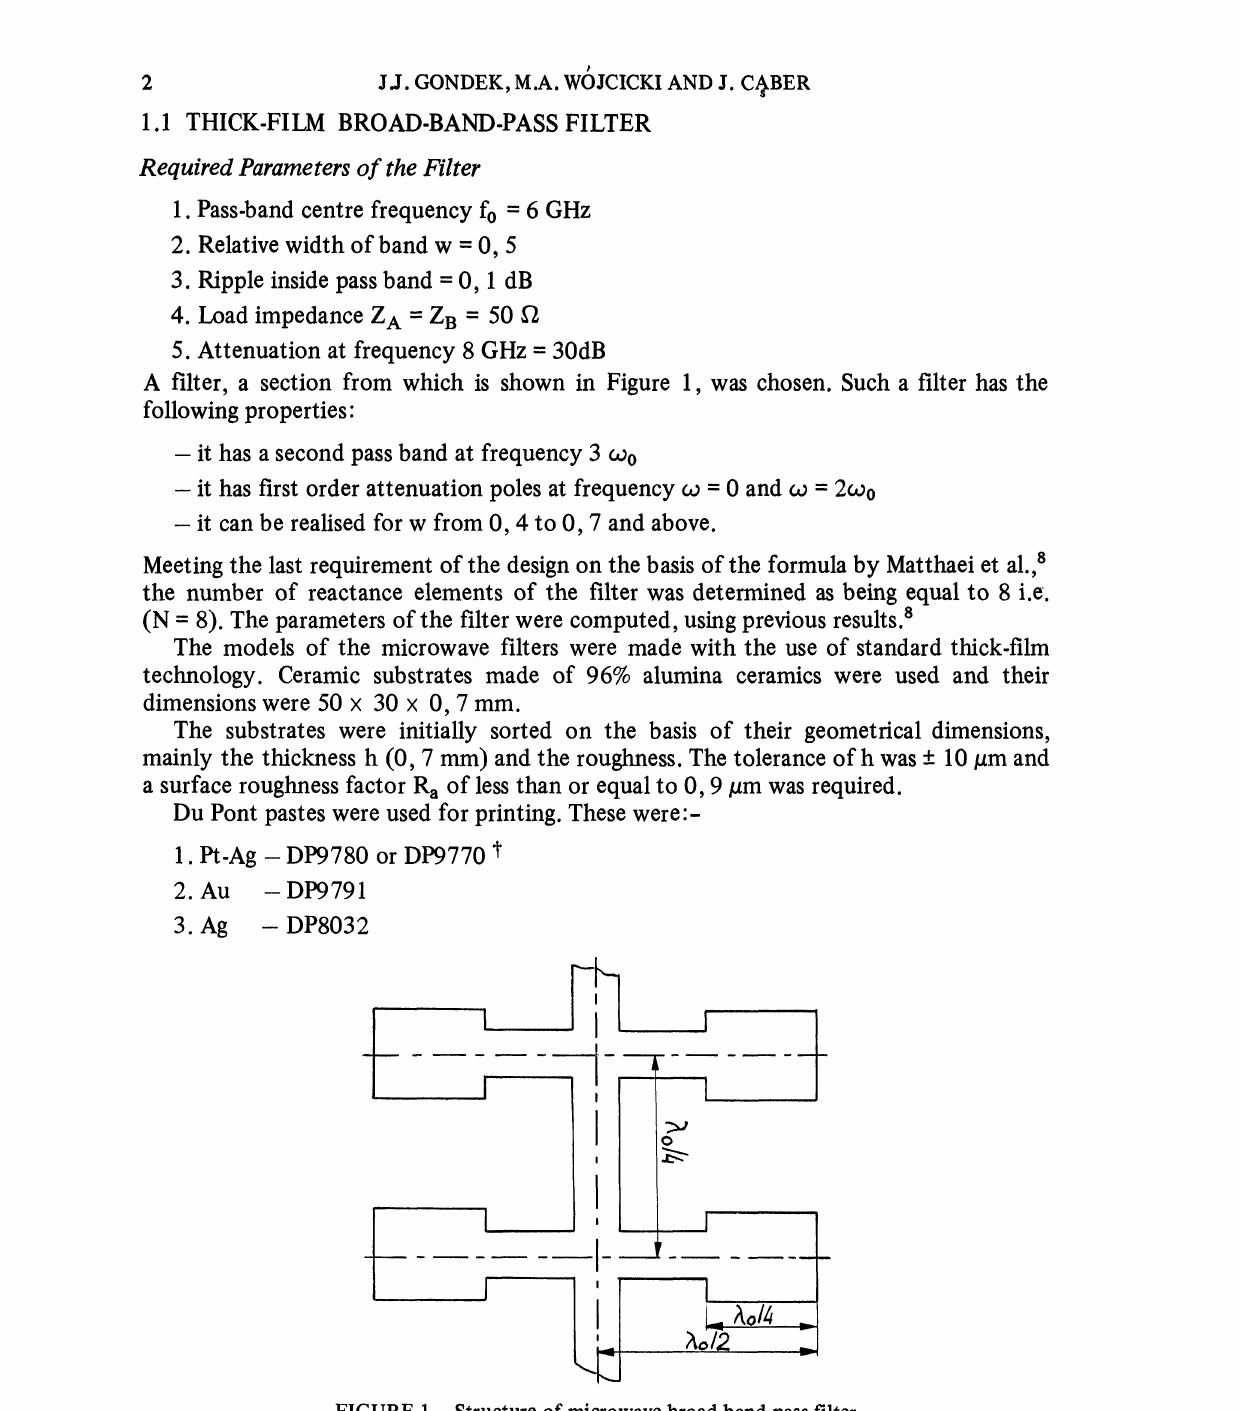
FIGURE Structure of microwave broad-band-pass